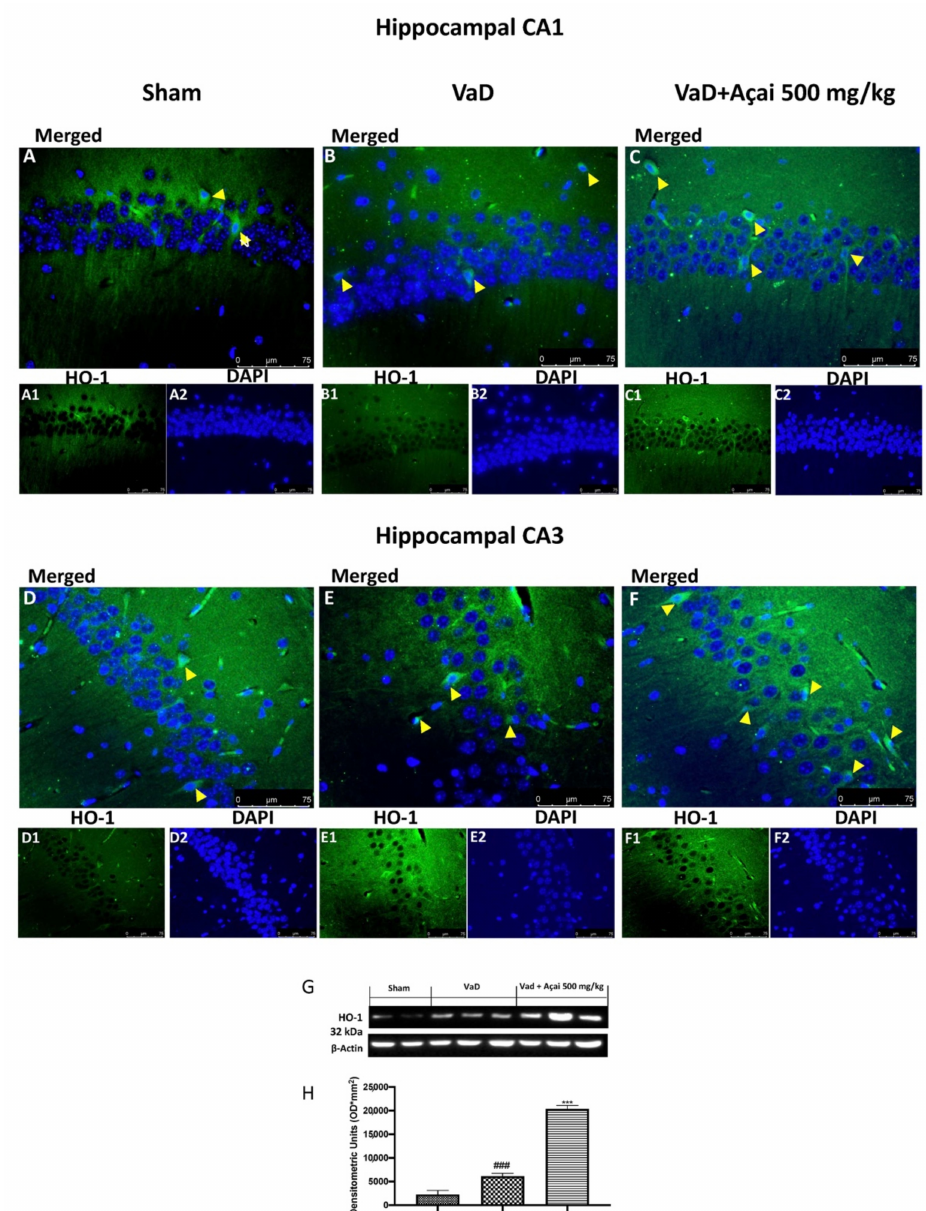
Figure 6. Açai berry increase HO-1 expression. Hippocampal CA1 figure of Sham ( A , A1 , A2 ), VaD ( B , B1 , B2 ), Açai Berry ( C , C1 , C2 ); Hippocampal CA3 figure of Sham ( D , D1 , D2 ), VaD ( E , E1 , E2 ), Açai Berry ( F , F1 , F2 ); ( G ) western blot of HO-1 and ( H ) relative densitometric analysis. Arrows indicate HO-1-DAPI merged cells in both hippocampal sections. Values are means ± SEM of six mice for all groups. Figures are representative from at least three experiments. See manuscript for further details. *** p < 0.001 vs. sham; ### p < 0.001 vs.